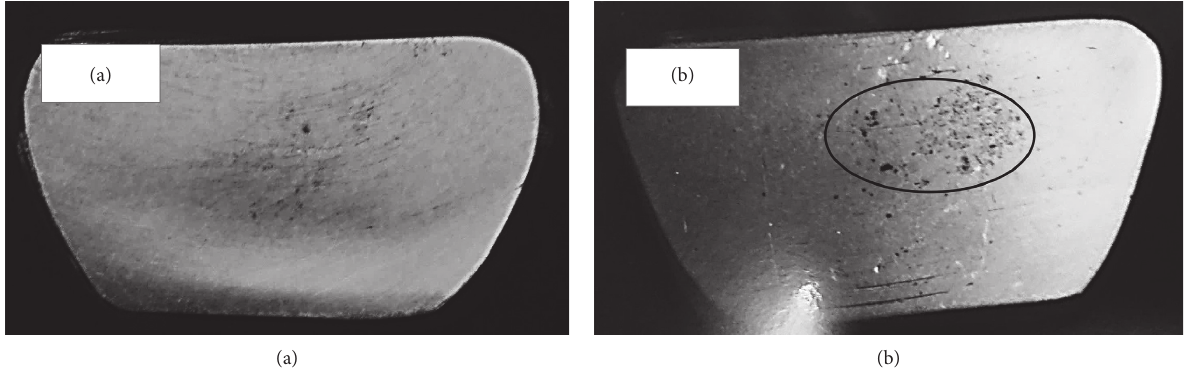
Figure 19: Mechanism of bifilm-porosity formation proposed by Dispinar and Campbell [43]. Arrow indicates the progress of